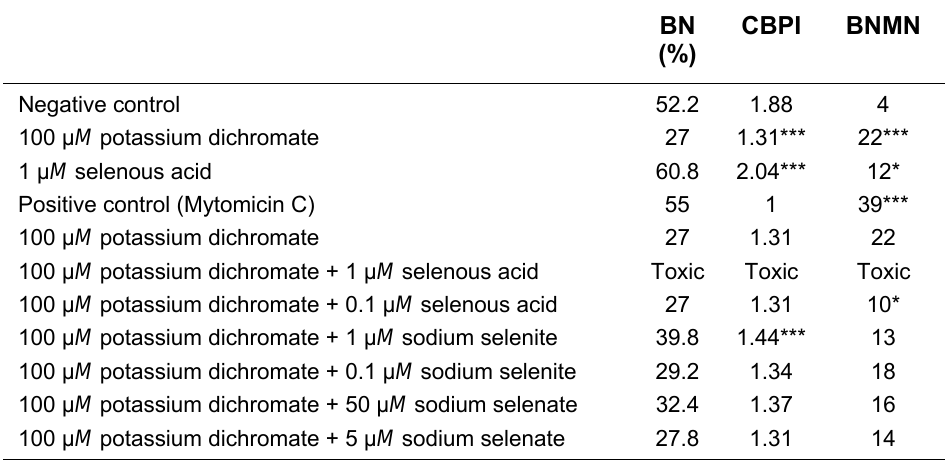
Assays Conducted with 100 μ M Potassium Dichromate and Selenium Compounds in Whole